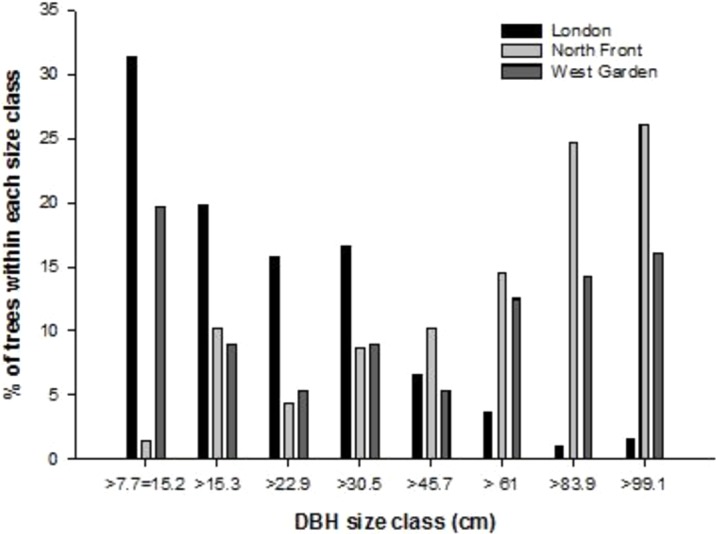
Size class distribution based on diameter at breast height (DBH) of trees in the North Front (black) and West Garden (grey), and City of London (London iTree Eco Project, 2015) with London data provided by Treeconomics and Forest Research available at: http://www.urbantreecover.org.